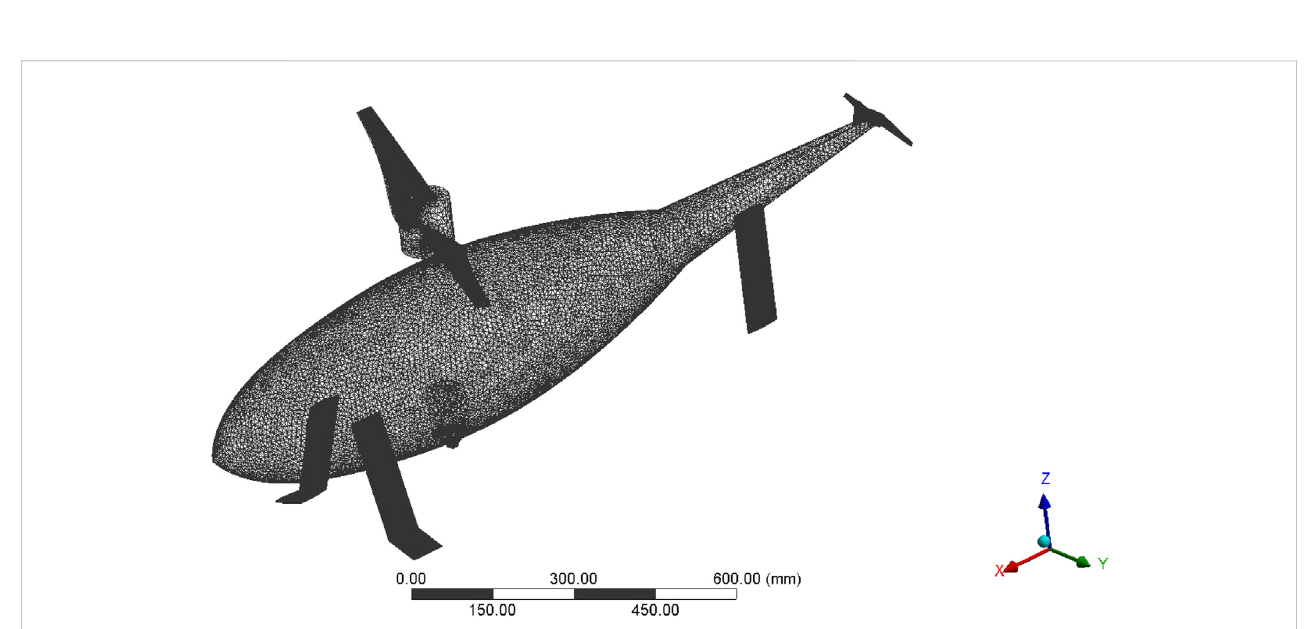
Mesh elements of half fuselage model – isometric view.